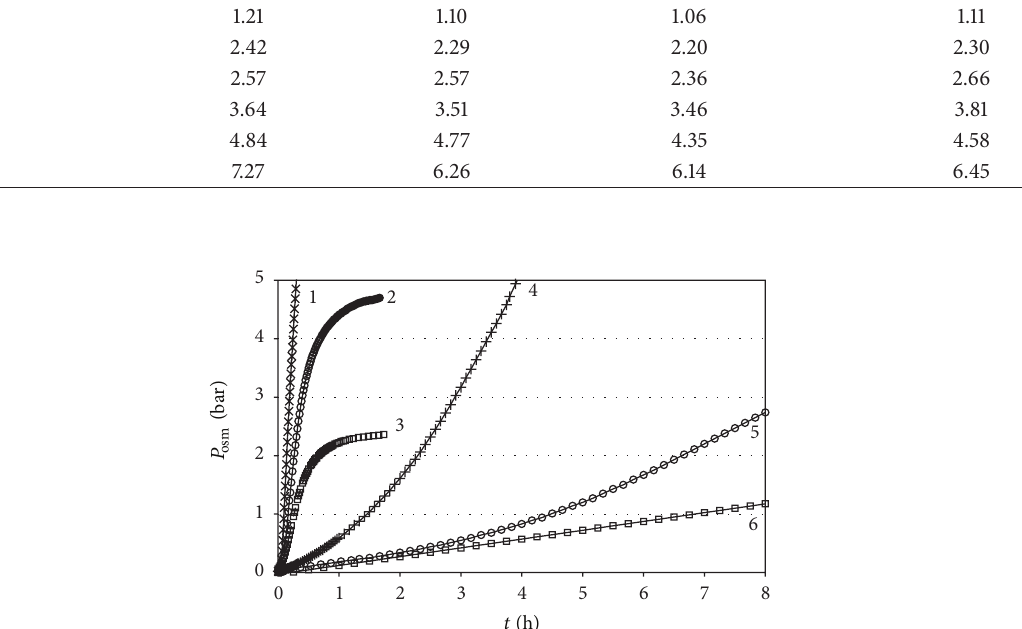
Table 1: Comparison of the osmotic pressure values at variable (open) and constant (closed) volume with the theoretical estimates. Solute concentration c [ mol/L ]